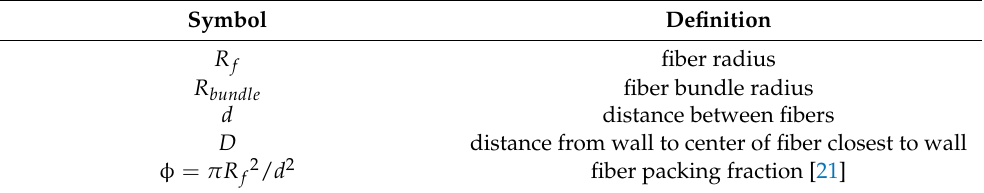
Table 1. Nomenclature for planar and circular fiber bundle domain